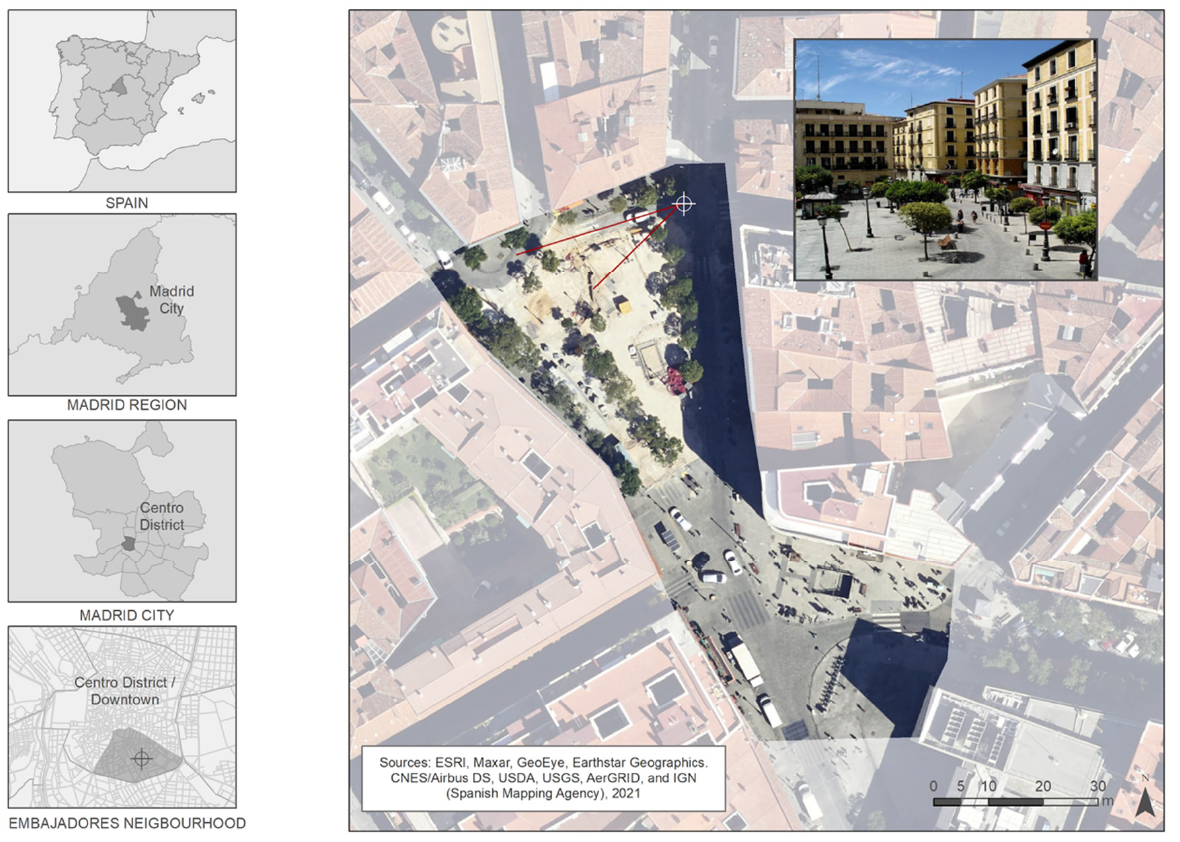
Figure 1. Study area—Lavapiés Square (Embajadores neighborhood, Centro district, city of Madrid). Data source: Spanish Mapping Agency, 2021.